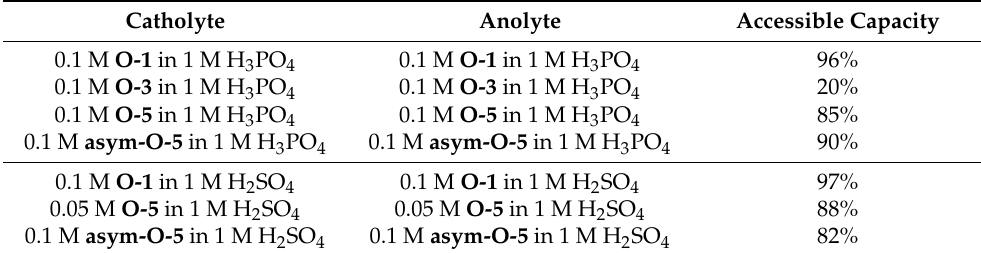
Figure 4. Discharge capacity of the symmetric cell tests of ( a ) O-1 , ( b ) O-3 , ( c ) O-5 and ( d ) asym-O-5 using the PS and GS cycling methods. The y -axis is normalized by dividing the discharge capacity value by its theoretical capacity. The potential was set at 0.3/ − 0.3 V with cut-off current at 3/ − 3 mA for the PS cycling method. The charge/discharge current applied in the GS cycling method was 50/-50 mA for O-1 , 30/ − 30 mA for O-3 and 20/ − 20 mA for O-5 and asym-O-5 with a cut-off voltage of 0.3/ − 0.3 V. Table 2. Accessible capacity of the four